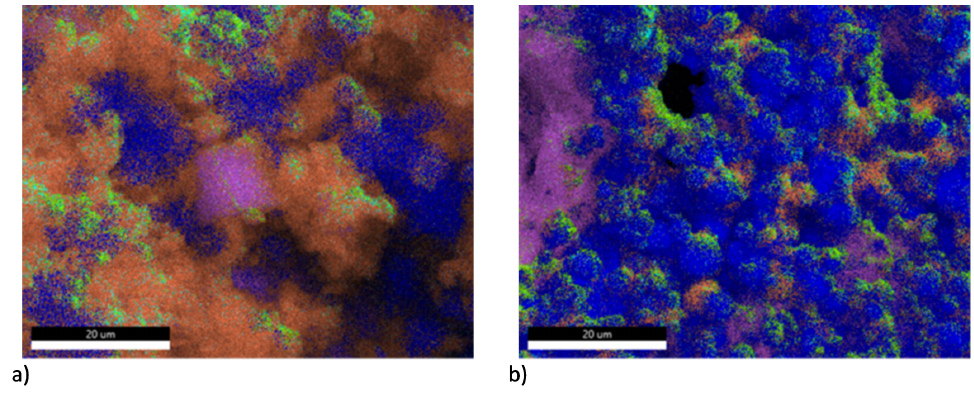
Figure 4. Result of EDS analysis for combustion products of samples Zn2 and Zn7. ( a )—Zn2 combustion products; ( b )—Zn7 combustion